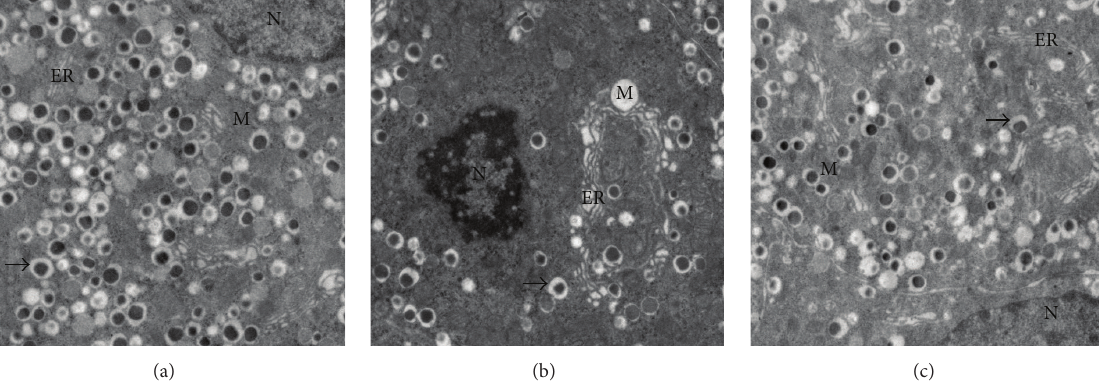
Figure 11: Electron microscopic analysis of pancreatic beta cells in different groups. (a) Ultrastructure of pancreatic beta cell showed that the nuclei, endoplasmic reticulums, mitochondria, and secretory granules were not abnormal in SO group (original magnification, × 3,000). (b) The changes of pancreatic beta cells in SAP group show condensed chromatin and loss of secretory granules, concomitant with severely dilatedendoplasmicreticulumsandswollenmitochondria(originalmagnification, × 3,000).(c)Milddilatationoftheendoplasmicreticulums, decrease of mitochondria damage, and increase of secretory granules were noted in 4-PBA group (original magnification, × 3,000). Note . Nucleus (N), mitochondria (M), endoplasmic reticulum (ER), and secretory granules (black